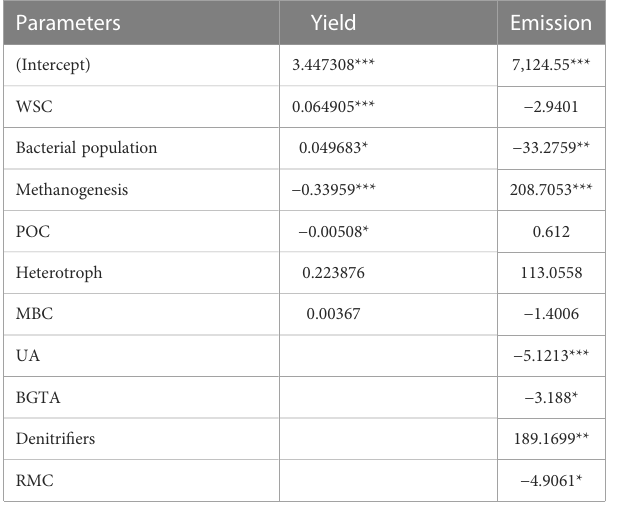
TABLE 7 Stepwise regression between yield and GWP with soil properties.